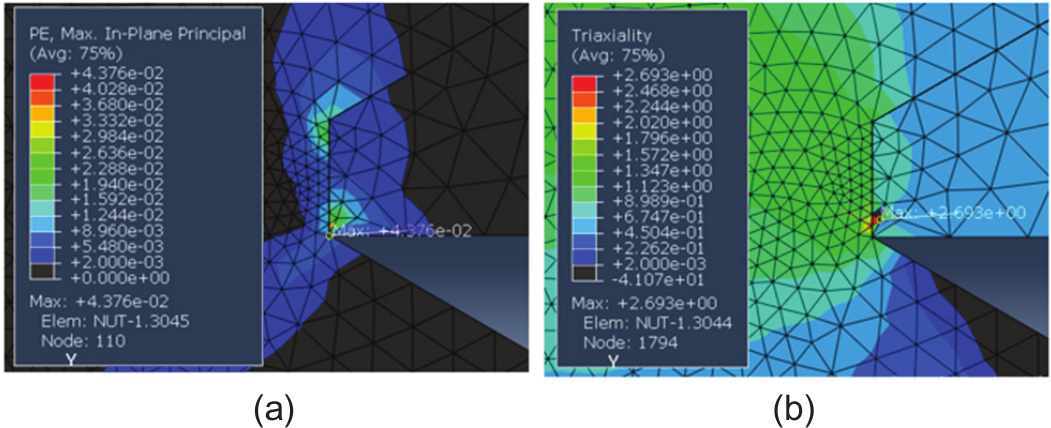
Figure 12. ( a ) Plastic strain and ( b ) triaxiality distribution around the first engaged thread .